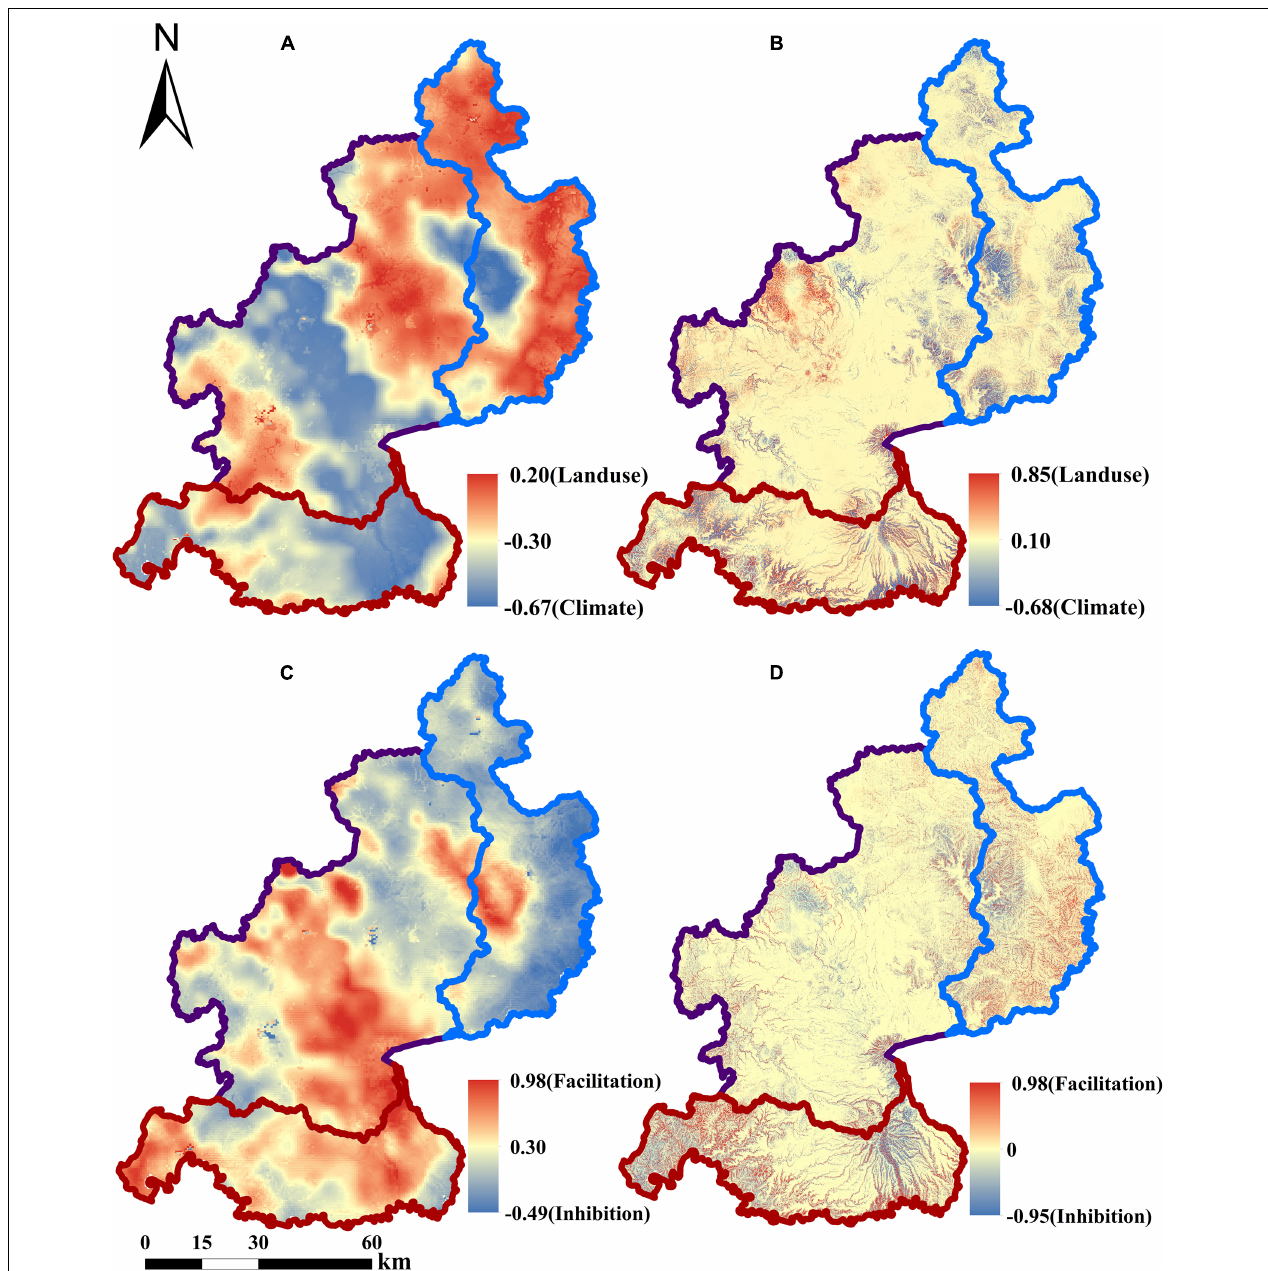
FIGURE 5 | Spatial distributions of the individual effects ( A : Water yield; B : Soil retention) and interactive effects ( C : Water yield; D : Soil retention) of LUCC and climate